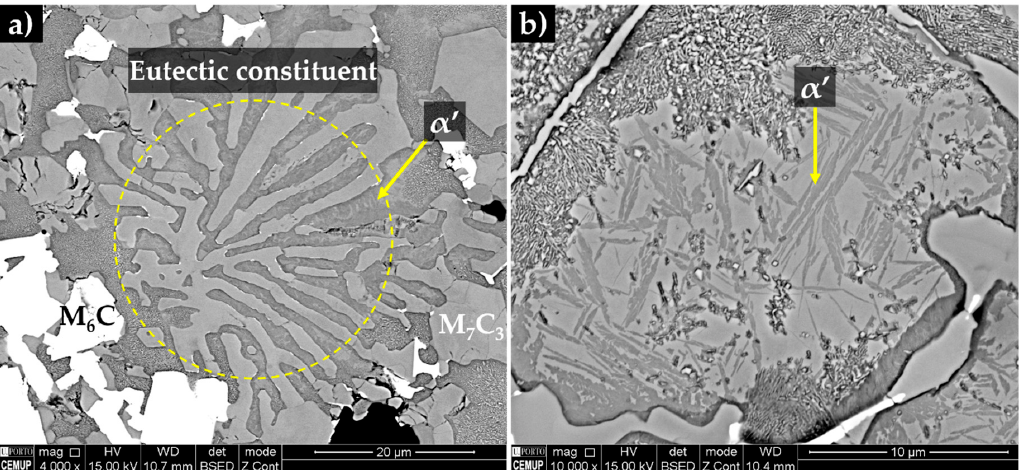
Figure 18. SEM-BSE images of the microstructure of the composite zone, ( a ) a detailed of a eutectic constituent (Fe,Cr) 7 C 3 and (Fe,W,Cr) 6 C + α ’) and ( b ) the martensite phase.